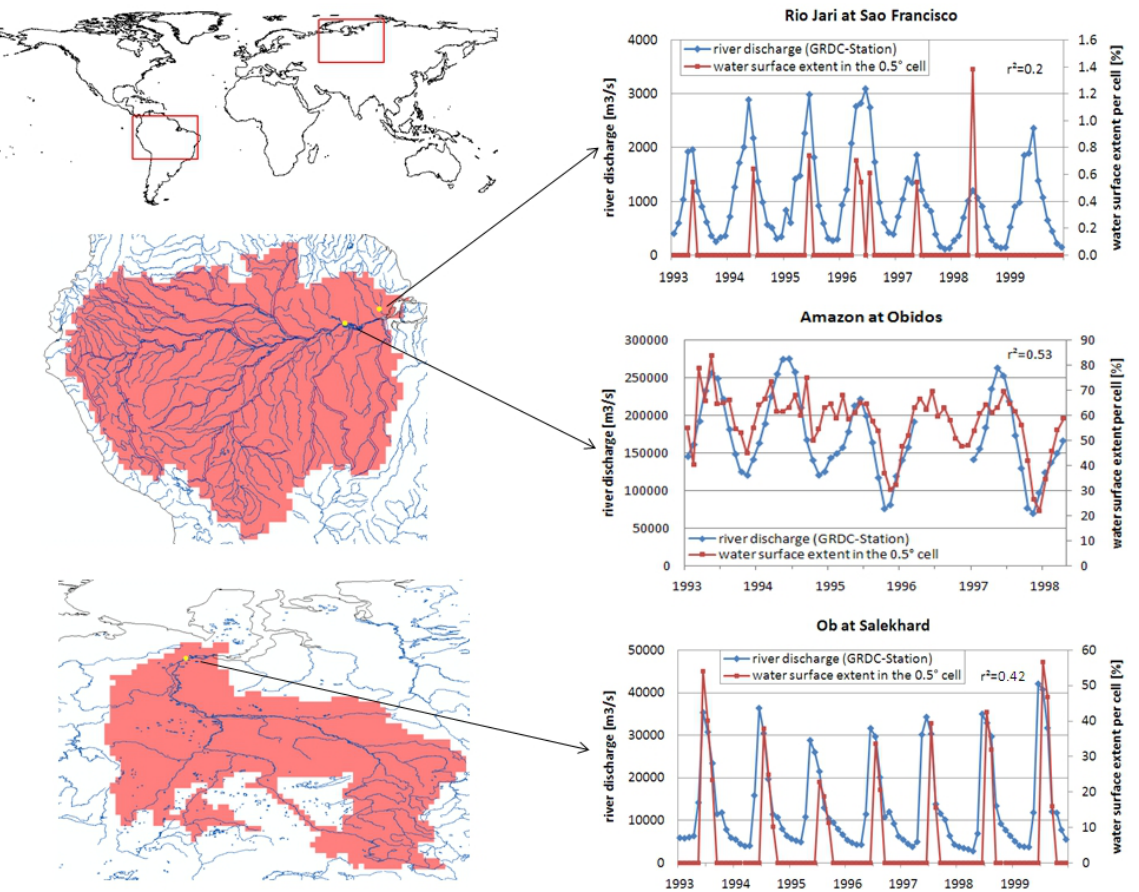
Fig. 4. Comparison of time series of observed river discharge (GRDC) at three gauging stations in the Amazon and Ob river basins and the extent of naturally inundated areas in the same 0.5 ◦ grid